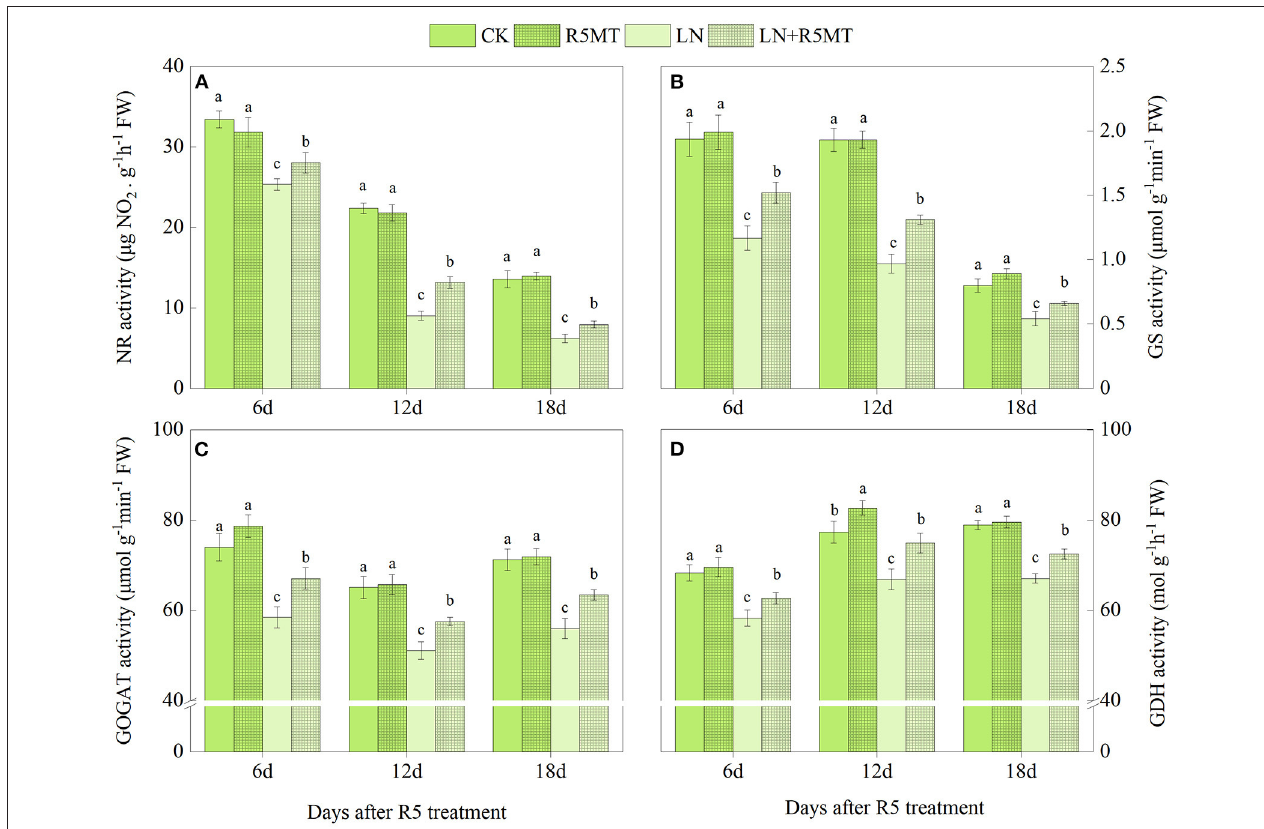
FIGURE 2 | The effect of spraying melatonin at R5 stage on the activities of nitrate reductase (NR, A ), glutamine synthetase (GS, B ), glutamate synthase (GOGAT, C ), and glutamate dehydrogenase (GDH, D ) in plant leaves under two N levels. CK, control nitrogen; R5MT, melatonin application at R5 stage under control nitrogen level; LN, low nitrogen; LN + R5MT, melatonin application at R5 stage under low nitrogen level. The values were presented as mean ± SE ( n = 3). Different letters in one measuring group indicate statistically significant differences when P ≤